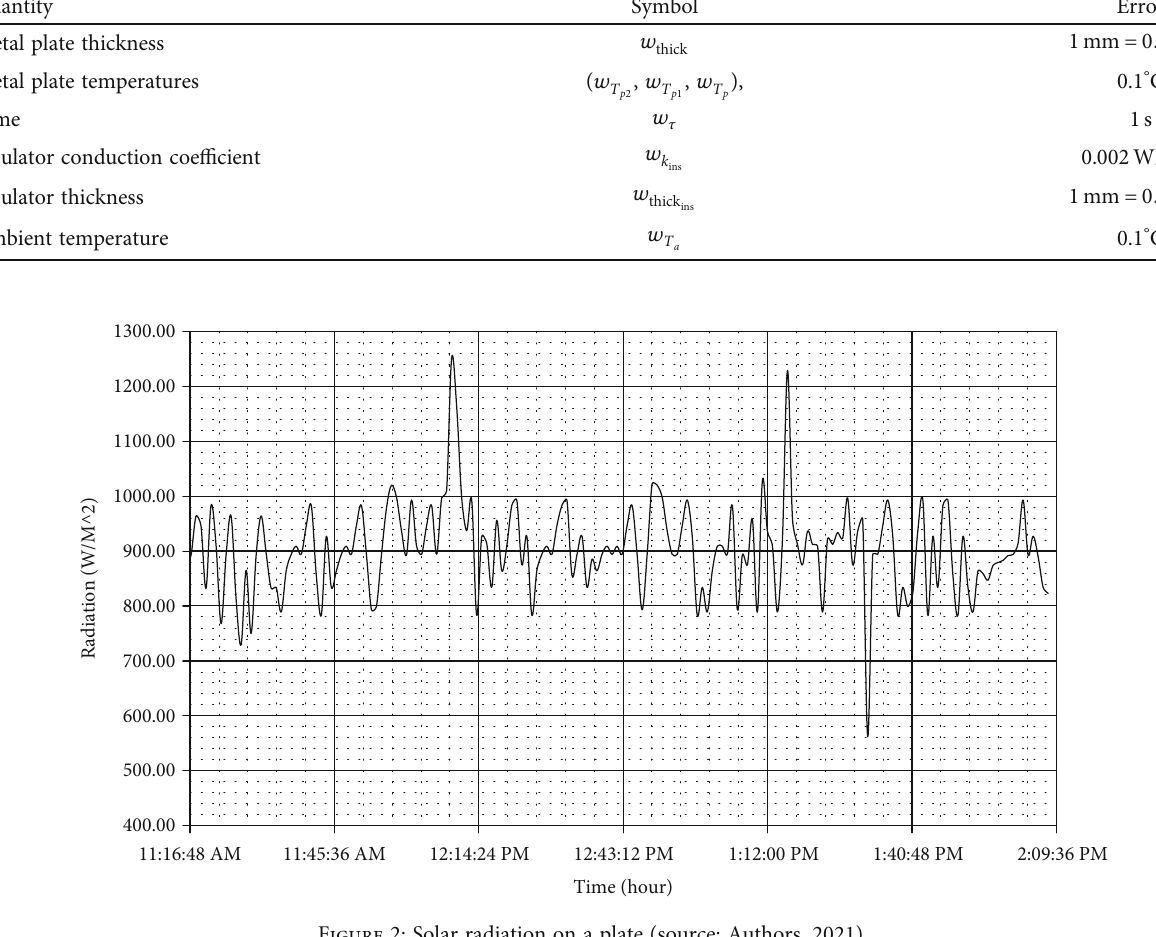
Figure 2: Solar radiation on a plate (source: Authors,